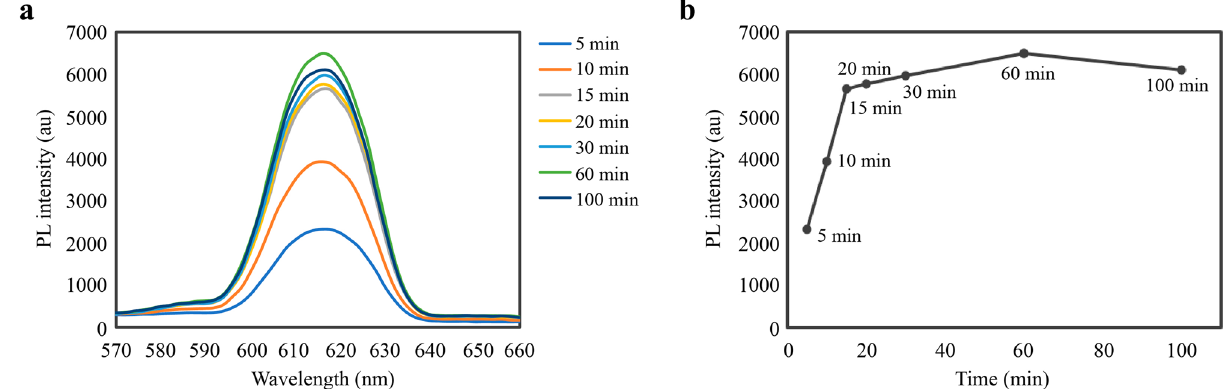
Figure 2. Optimization of the assay time. ( a ) Detection of fluorescence intensity under different fluorescence- developing times. ( b ) Identification of the optimal fluorescence-developing time. PL photoluminescence.